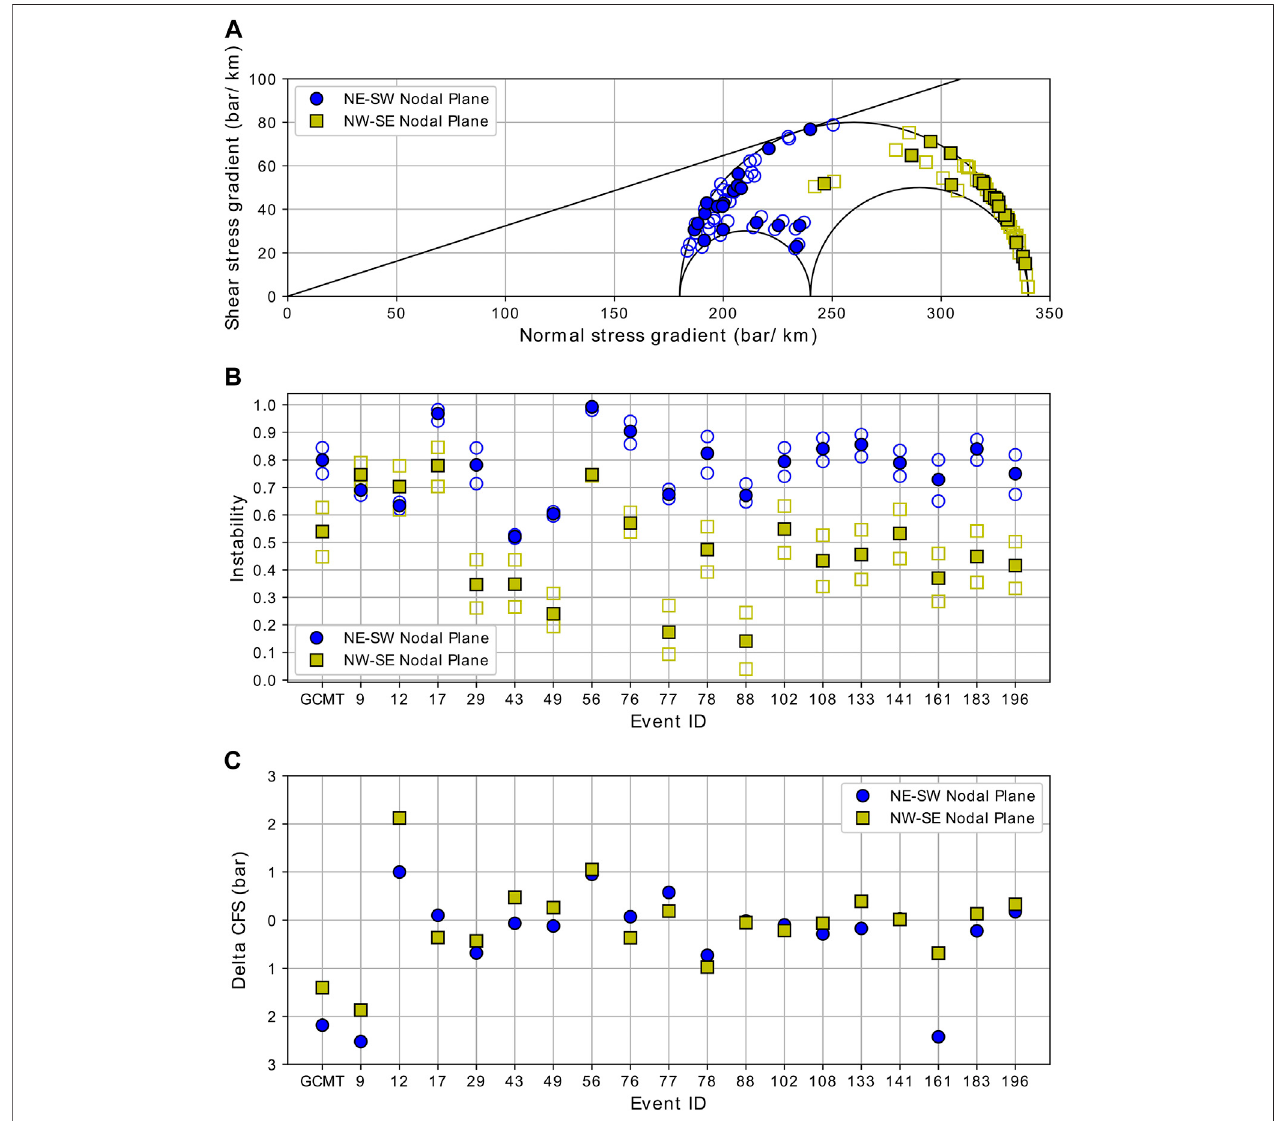
FIGURE 9 | Instability of NE-SW and NW-SE aftershock focal mechanism nodal planes plotted in Mohr diagram (A) and in a graph of instability vs. event number (B) .The Δ CFSof2016PidieJayamainshockresolvedintheNE-SWandNW-SEaftershockfocalmechanismnodalplanes (C) .Theopenbluecircleandyellowsquarein (A) and (B) are instability values calculated using SH N35.1 ° E and N42.9 ° E. The others are calculated using SH N39 °